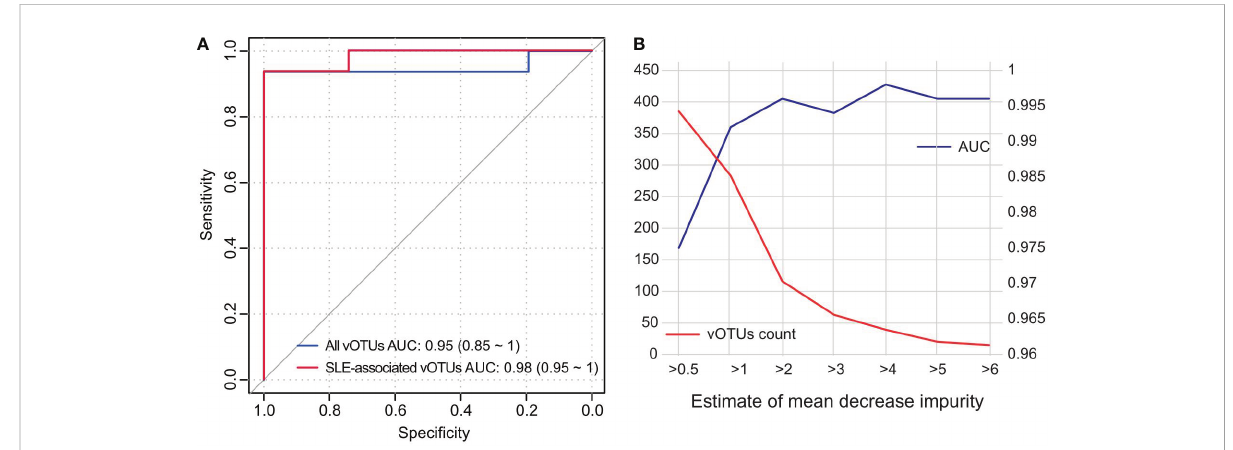
FIGURE 5 Classi fi cation of SLE status by the abundance of gut virome. (A) ROC analysis for the classi fi cation of SLE patients and healthy controls. The performances of models trained and tested by all vOTUs and 426 SLE-associated vOTUs are shown. (B) AUC values for different numbers of vOTUs used in the random forest models. The number of vOTUs is shown by the red line on the left axis, and the AUCs are shown by the blue line on the right